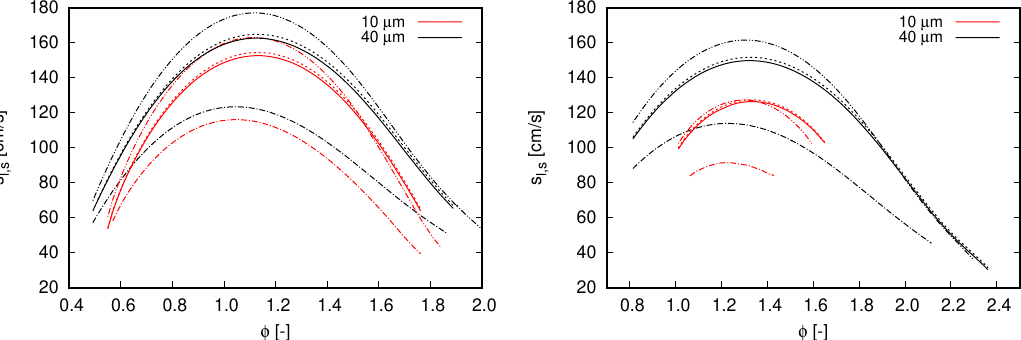
Figure 9. Flame speed computed with different diffusion transport modeling strategies for flames propagating in droplet mists. Continuous lines, complex; dashed lines, mixture-averaged without thermal diffusion modeling; dash-dot-dot lines, mixture-averaged with thermal diffusion modeling; dash-dot lines, unitary Lewis number. ( left ) α H = α H 2 O